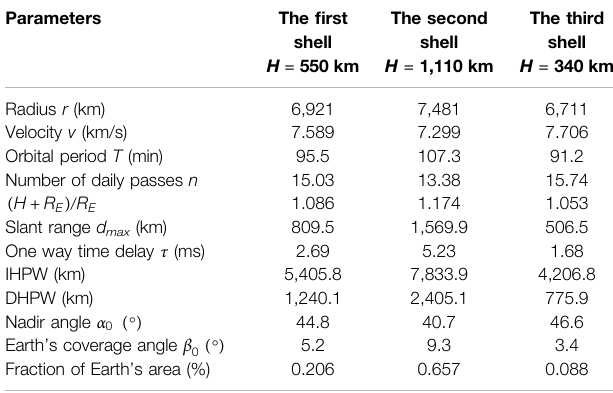
TABLE 7 | Parameters comparison of three orbit shells of Starlink LEO constellation ( ε 0 (cid:1) 40 ° ) .